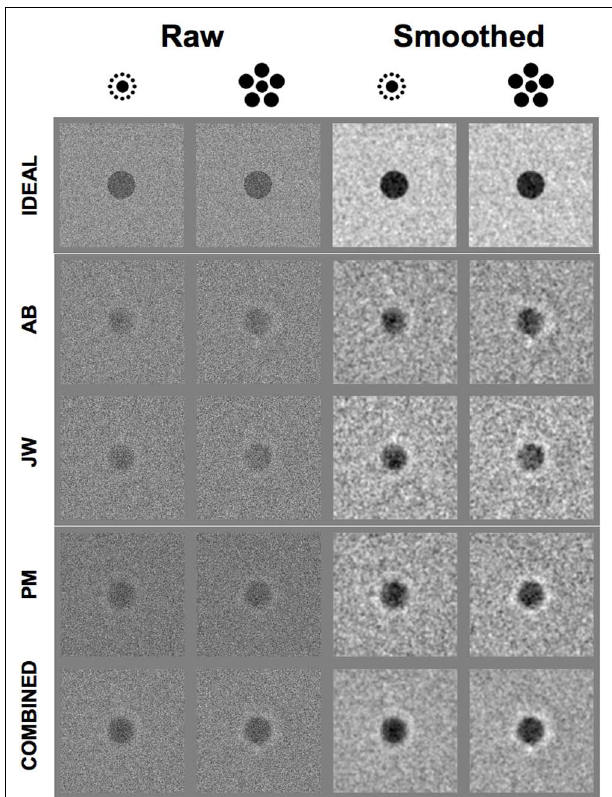
FIGURE 4 | Raw (left two columns) and smoothed (right two columns) classification images for the ideal observer, three human observers and the combined data across all three human observers in each condition of Experiment 2 (see text for